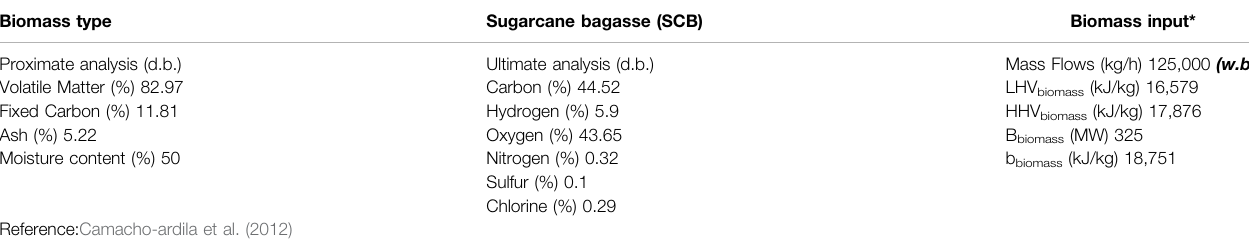
TABLE 1 | Feedstock composition. Biomass type Sugarcane bagasse